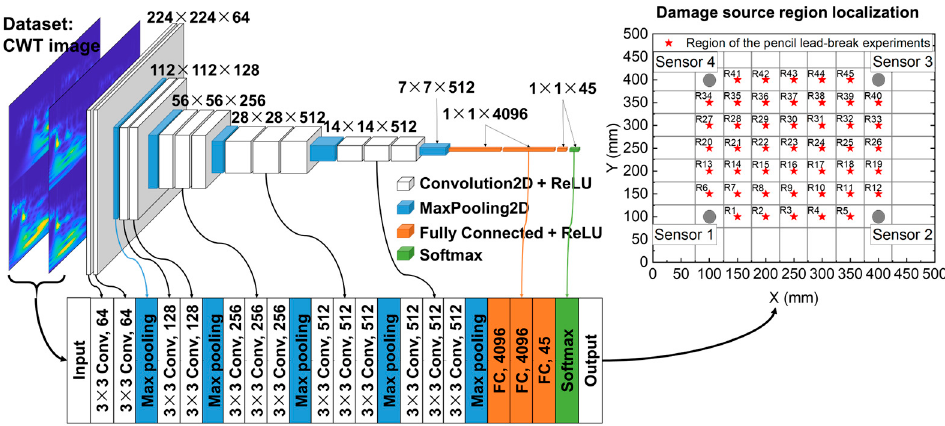
Figure 6. A deep learning-based framework for locating damaged areas.